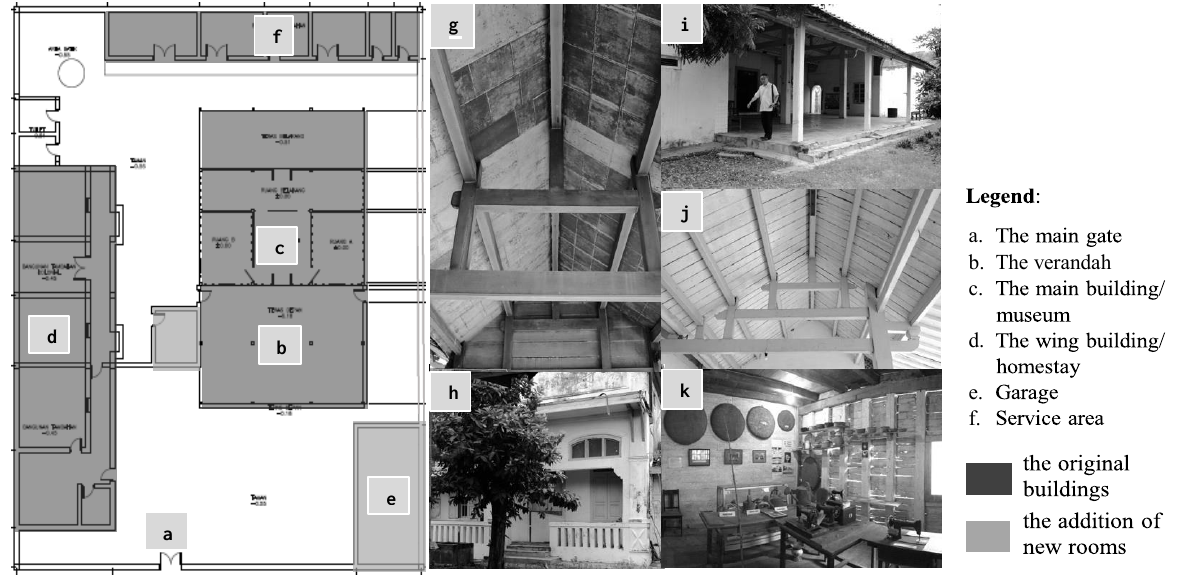
Figure 10. The floor plan showing the transformation of the main building and the left wing of the Museum, (g) the exposed roof construction frame, (h) the left wing with the Dutch colonial style, (i) the verandah with wood frame structure, (j) Dou gong